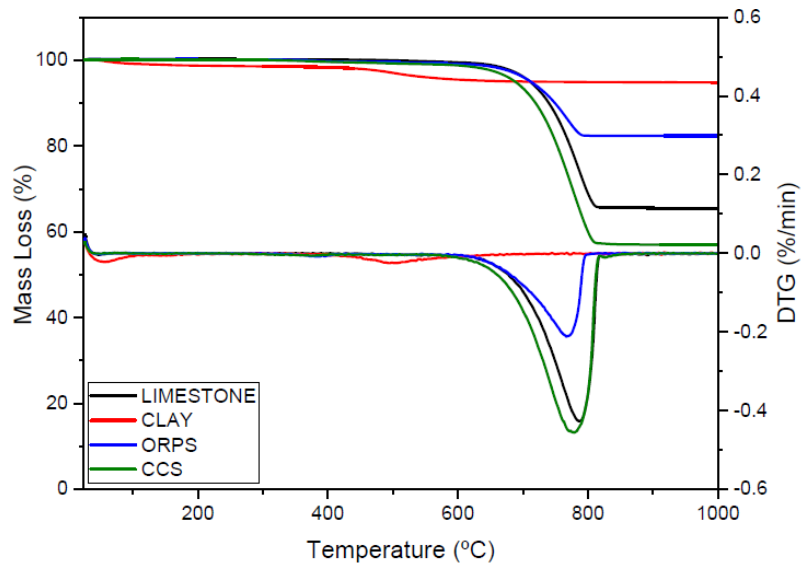
Figure 6. Thermogravimetric analyses of the raw materials.